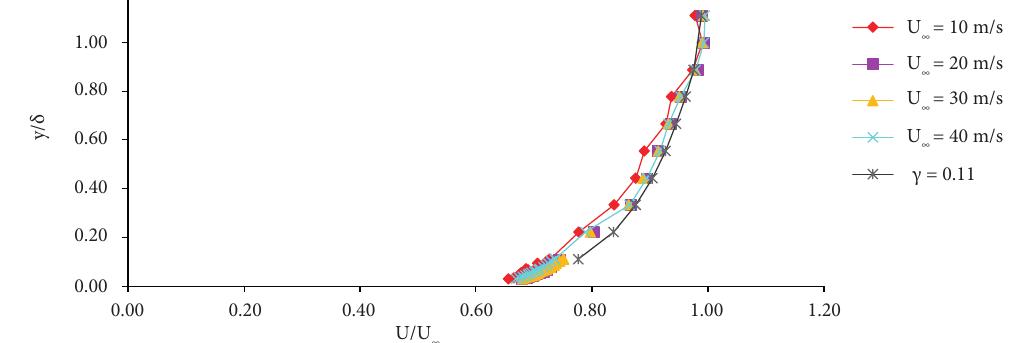
Figure 5. Velocity profi les obtain for different wind speeds.